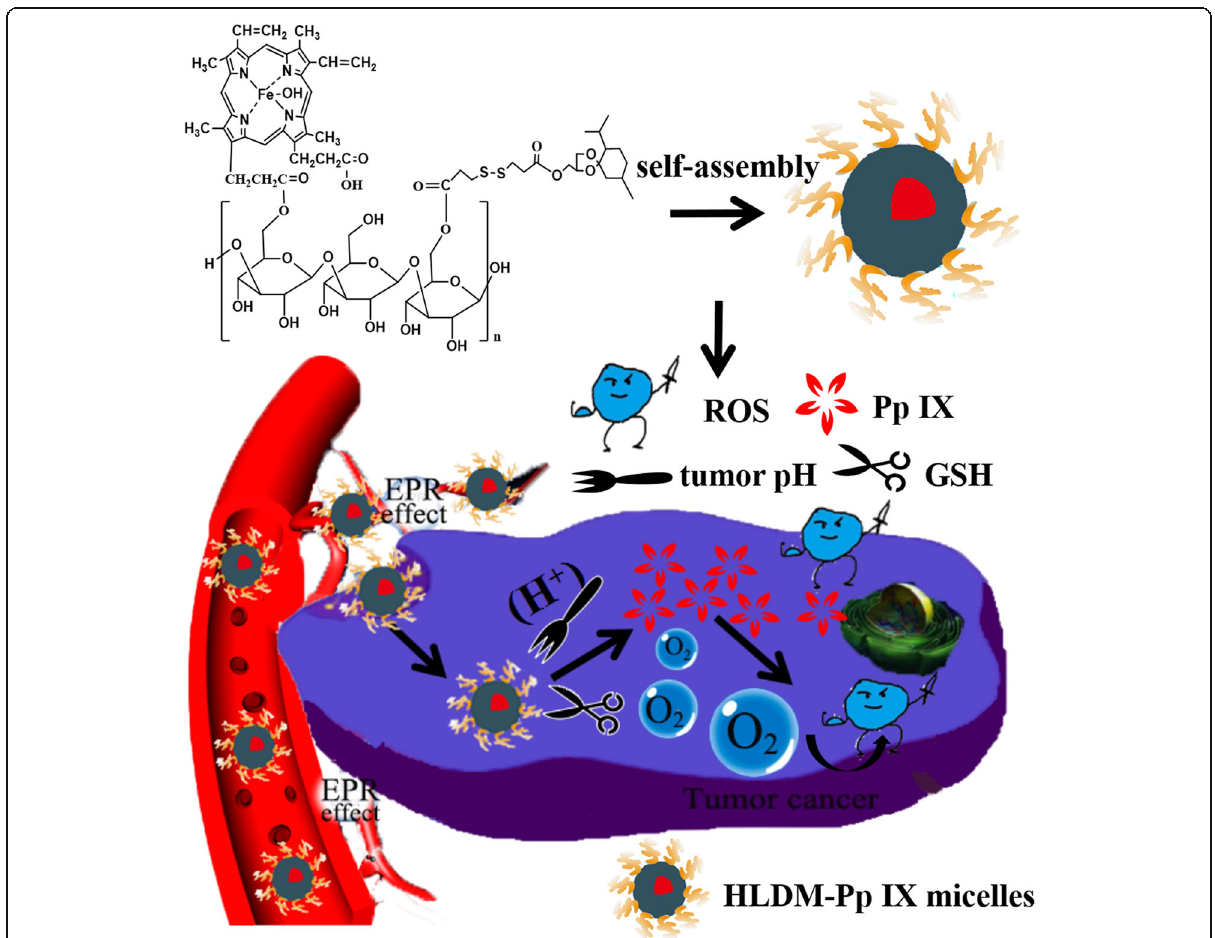
Fig. 1 Schematic illustration of laminarin-based nanomedicine (HLDM) used to deliver the photosensitizer for tumor